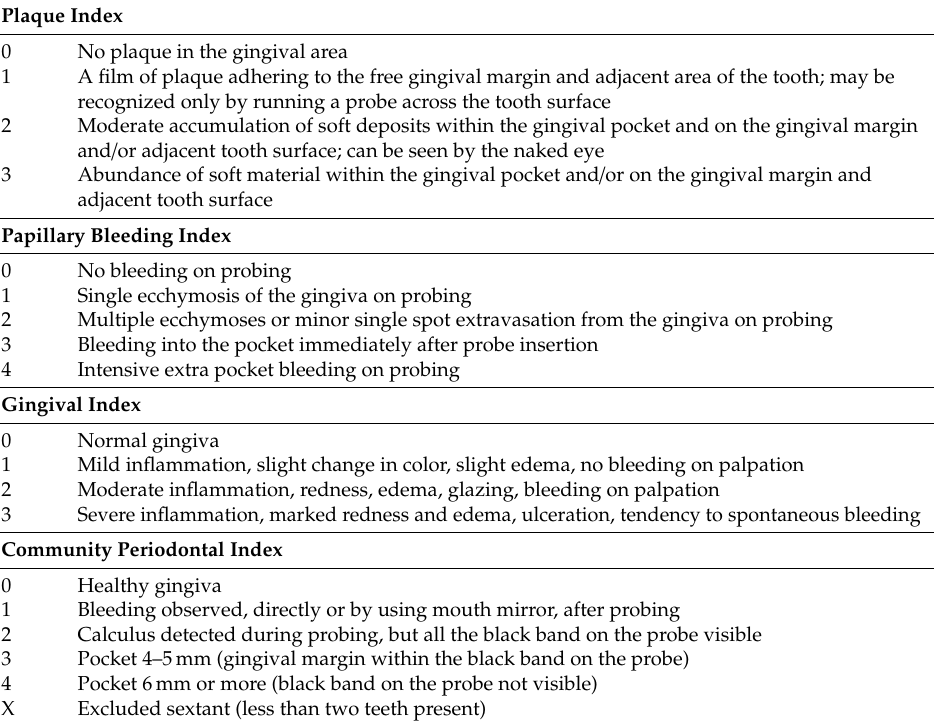
Table 1. Criteria for representative periodontal